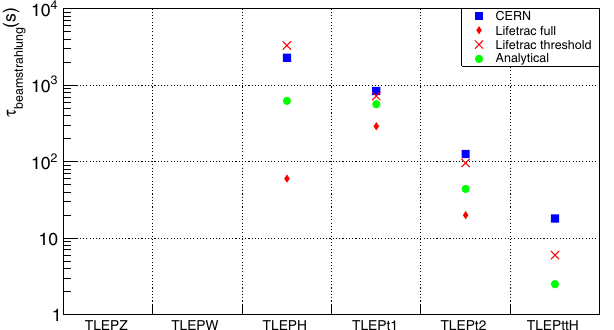
FIG. 4. Bunch length for different scenarios of TLEP operation. Blue squares are taken from Table I, red diamonds are L IFETRAC results with full spectrum of beamstrahlung, red crosses are L IFETRAC results if beamstrahlung is considered for emission of photons with energy higher than acceptance, and green dots are our analytical calculations.